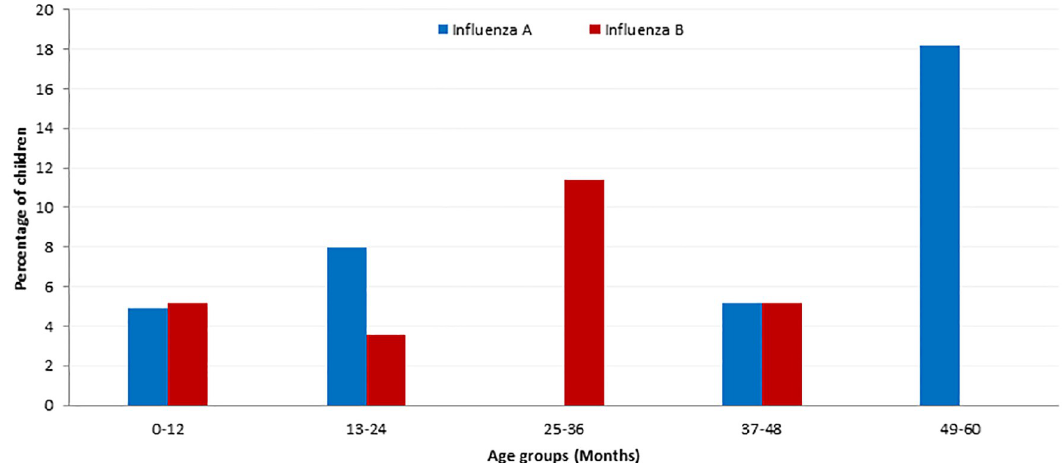
Fig 1. Age distributions of Inf-V infections in children with ARI. The median age of children with ARI was 13 months (Mean ± SD; 13.166 ± 12.394). Out of the 54 Inf-V infections, 33 (61.1%) were less than 12 months old. The rate of Inf-V infection increased with the increase in age in children less than 5 years